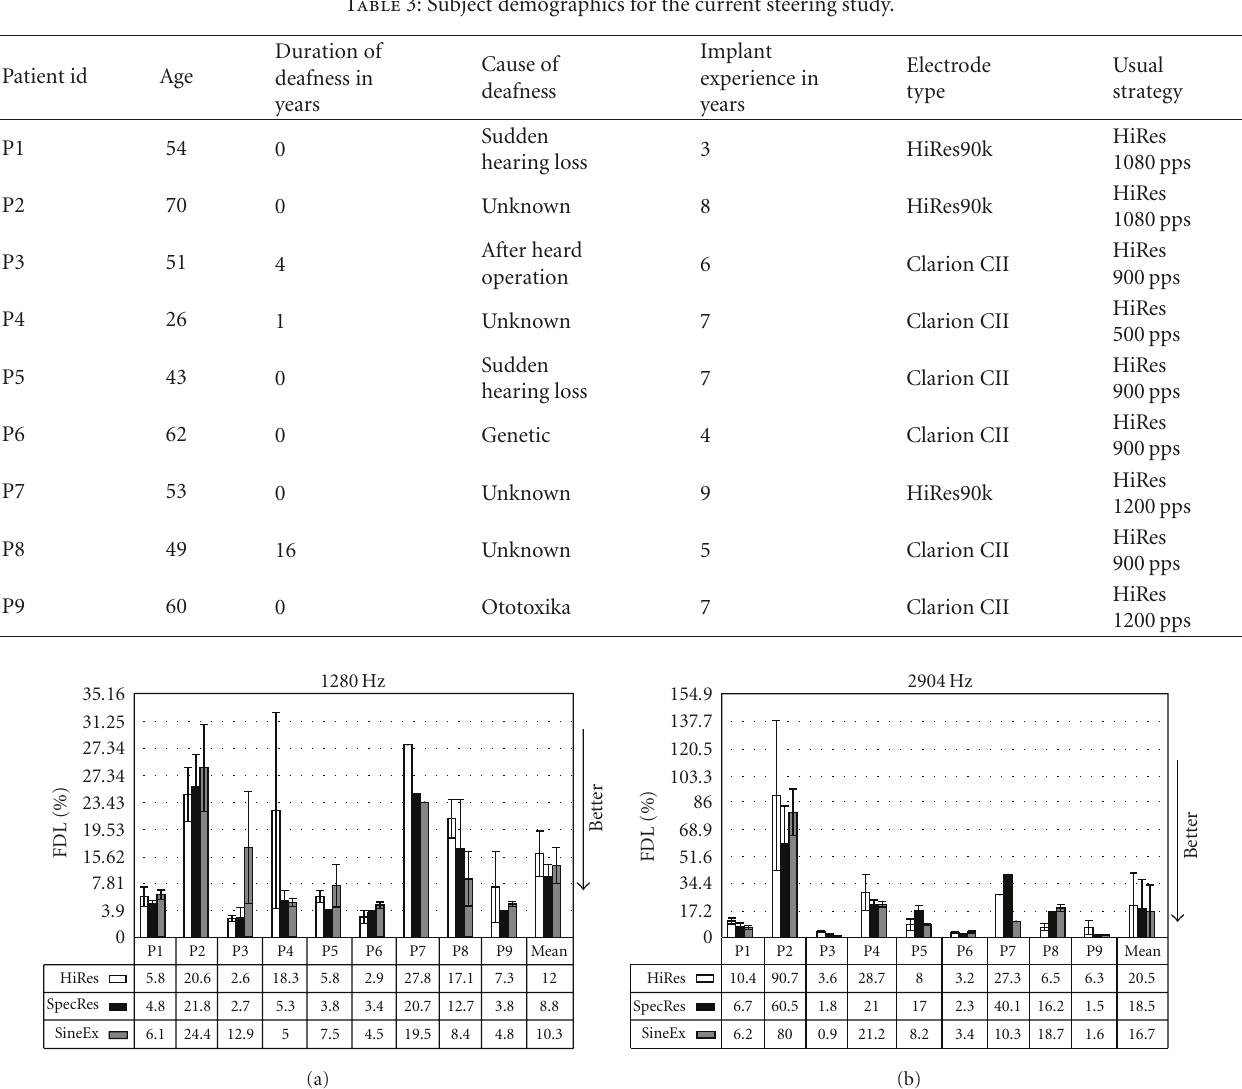
Table 3: Subject demographics for the current steering study.